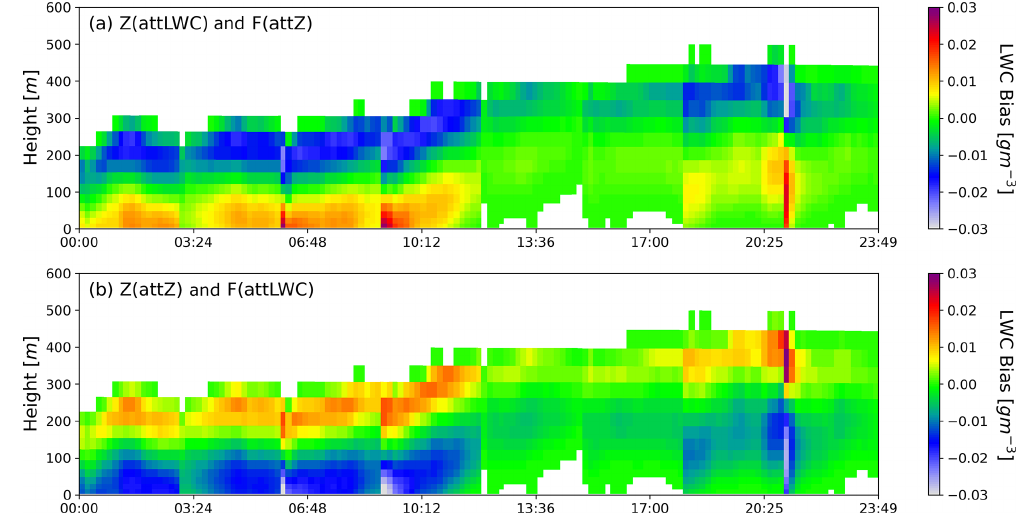
Figure A1. Bias in retrieved LWC with respect to true LWC for different attenuation considerations in the retrieval algorithm.